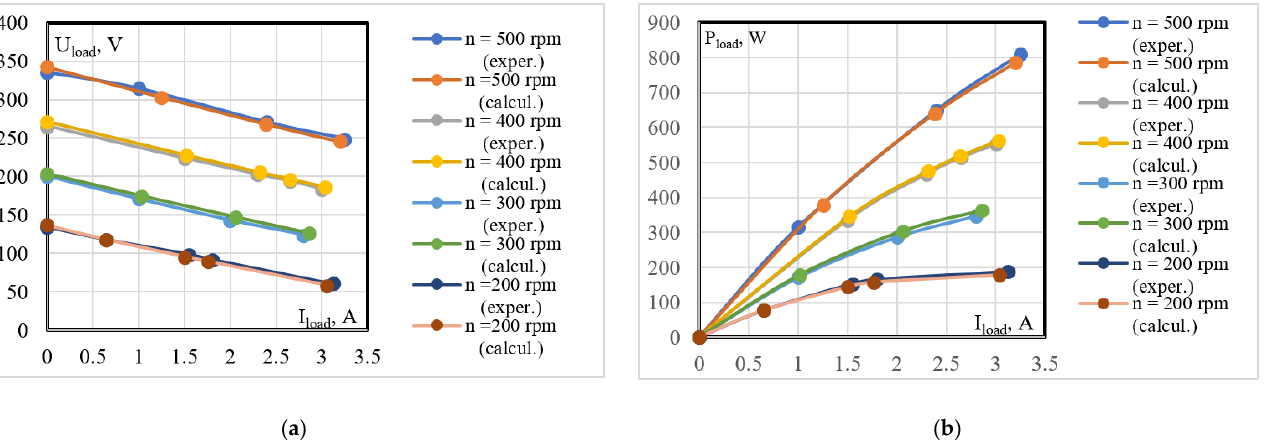
Figure 14. Output characteristics of the radial machine with N42 PMs: ( a ) terminal voltage vs. load current, ( b ) output power vs. load current.